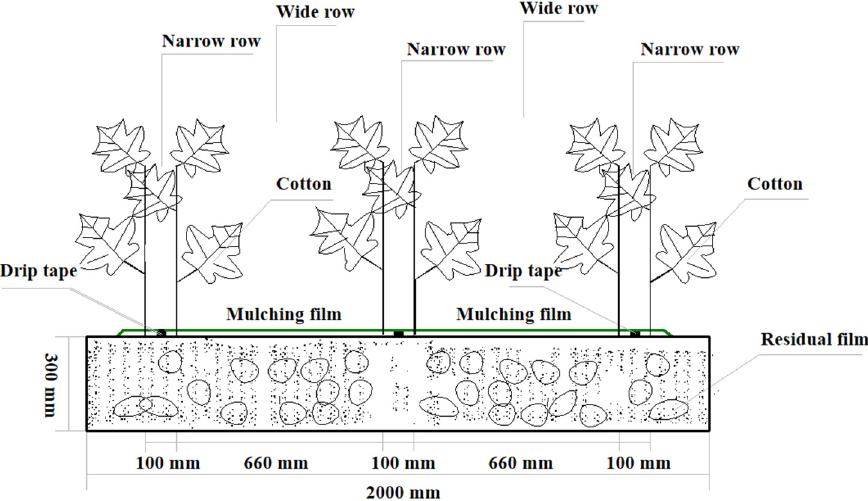
Figure 1. Distribution of residual film in soil under cotton farming mode.